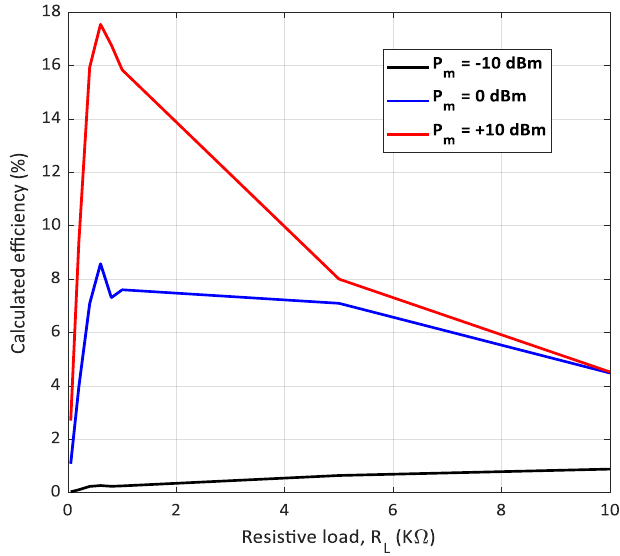
Figure 14. Efficiencies for different R L and P m for the rectifier circuit in Approach I.